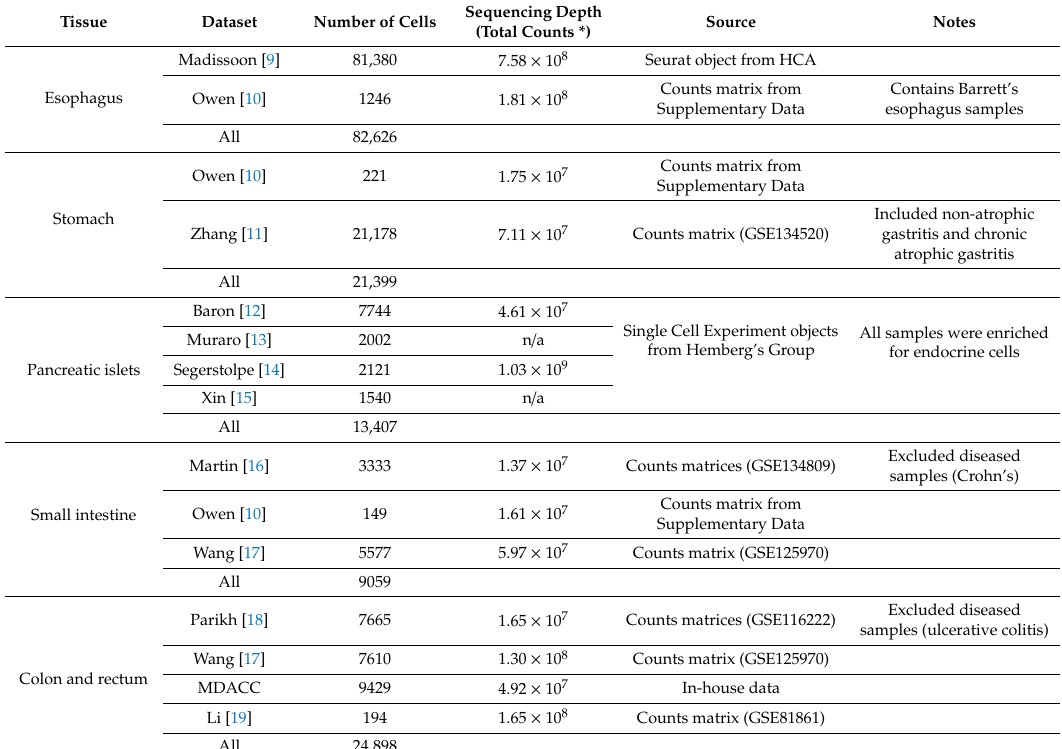
Table 1. Summary of datasets used in the